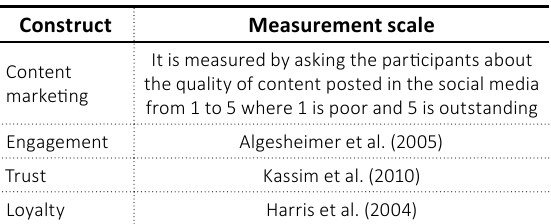
Table 1. Measurement scale of